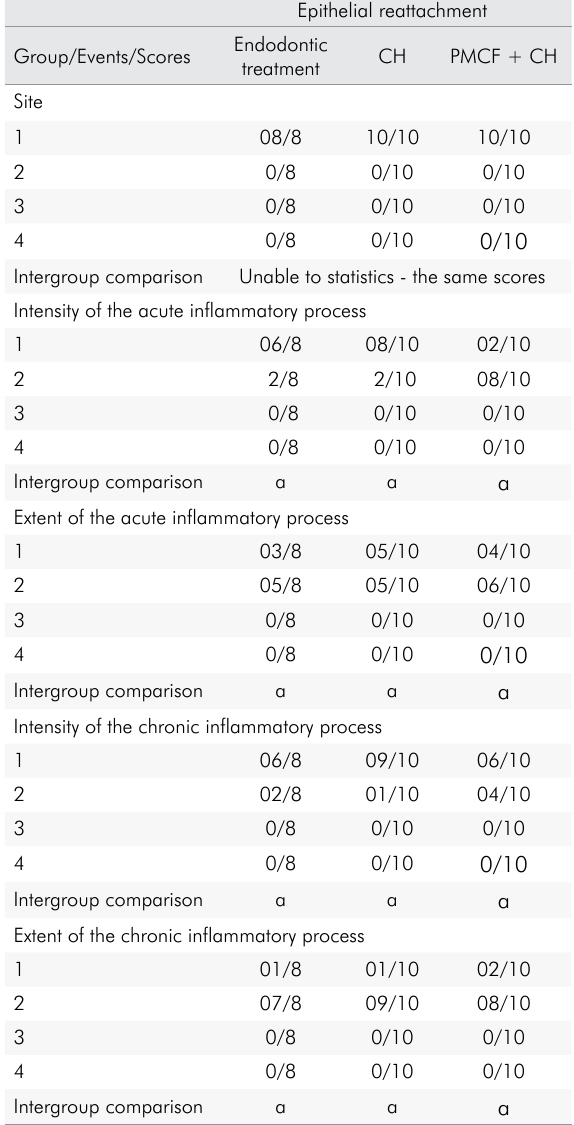
Table 2. Distribution of scores and statistical analysis of the histomorphometric events associated with epithelial reattachment (Wilcoxon signed ranks test at 5% significance